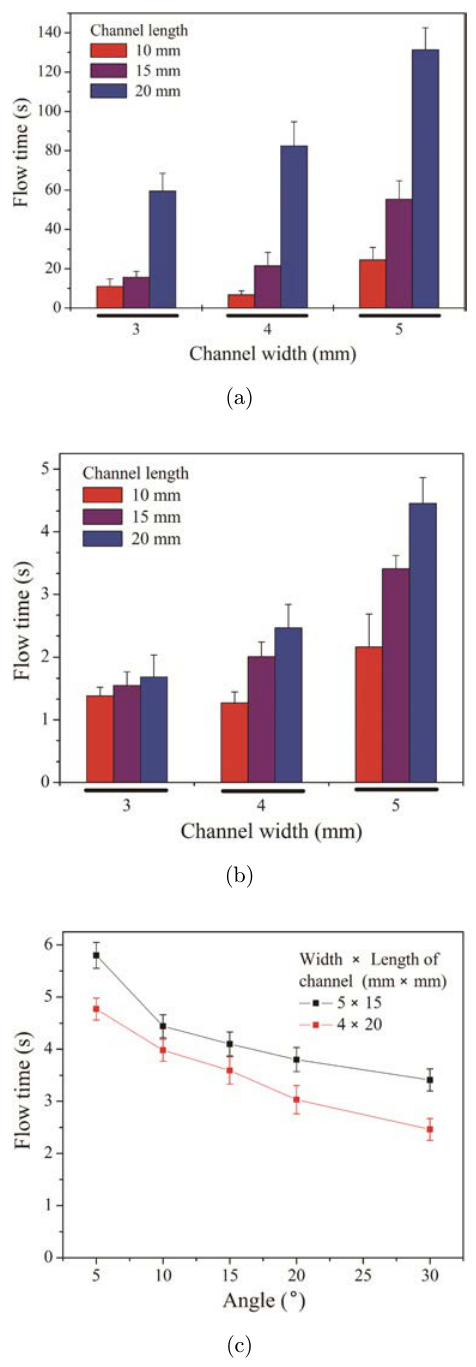
Fig. 3. Characteristics of liquid transport on lab-on-paper devices. (a) Relation between the channel size and the time for 40- (cid:2) L dye solution to wick through the paper channel only under the action of capillary force. (b) Relation between the channel size and the time it took for 40- (cid:2) L dye solution to °ow through the paper channel at the inclination angle of 30 (cid:2) . (c) The time for 40- (cid:2) L dye solution to °ow through two di®erent paper channels is plotted against the angle of inclination. The error bar is the standard error from eight independent